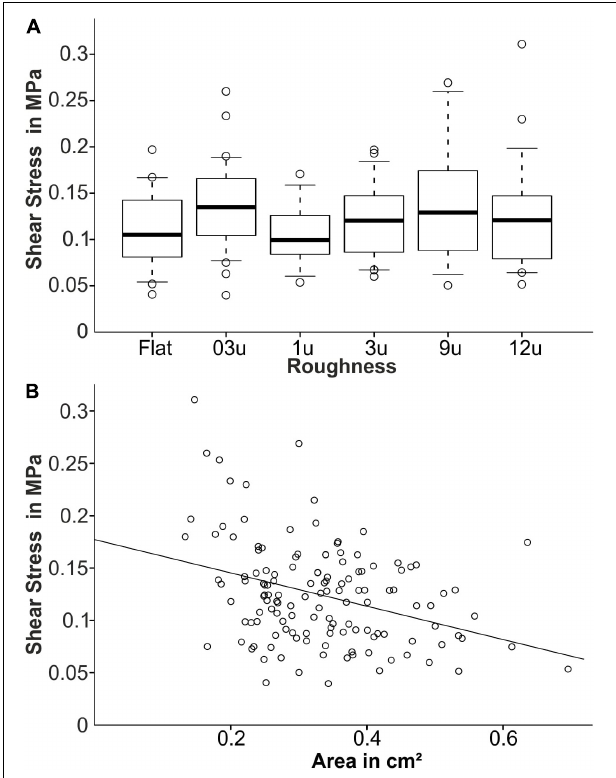
FIGURE 7 | The attachment strength of PVS samples during the field experiment 2. (A) The average shear stress (MPa) for each roughness. (B) The relationship between measured shear stress and the barnacle basal plate area. The fitting line corresponds to an assumed linear relationship between both shear stress and basal plate